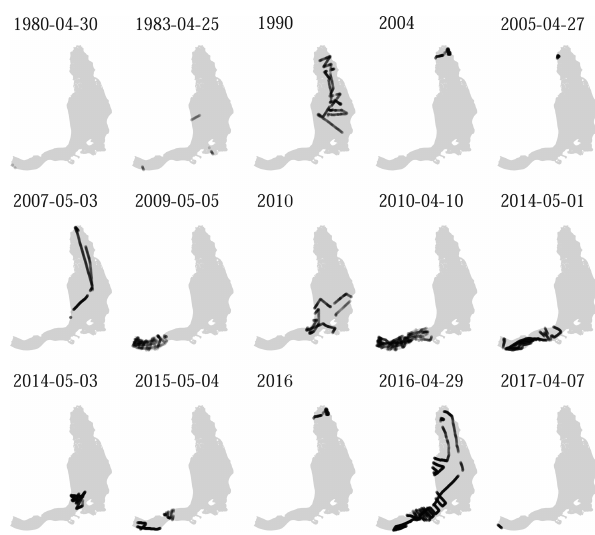
Figure 9. All thickness point measurements in GlaThiDa inter- secting the RGI outline (RGI60-07.01464) for Kronebreen, Sval- bard (78.992 ◦ N, 13.384 ◦ E), by survey date (or year, if the date is unknown). The corresponding studies referenced in GlaThiDa are Dowdeswell et al. (1984, 1986), Björnsson et al. (1996), Lindbäck et al. (2018), Kristensen et al. (2008), and Paden et al. (2018).